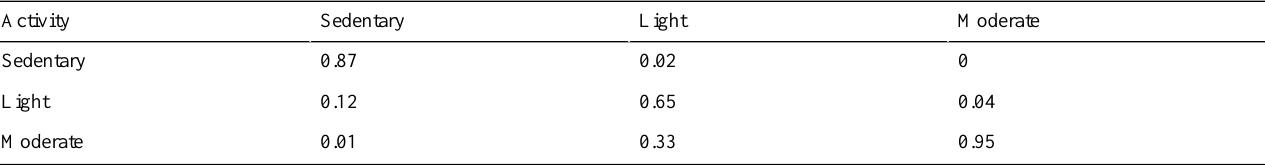
Table 6. Normalized confusion matrix showing the percentage of correctly classified instances for the random forest model used for activity type classification tasks based on intensity level. Each column shows the actual activity and rows represent the predicted labels.